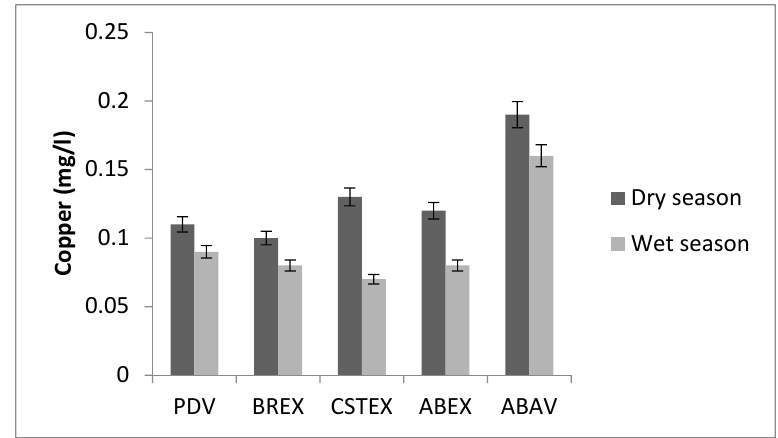
Figure 2. Copper concentration.